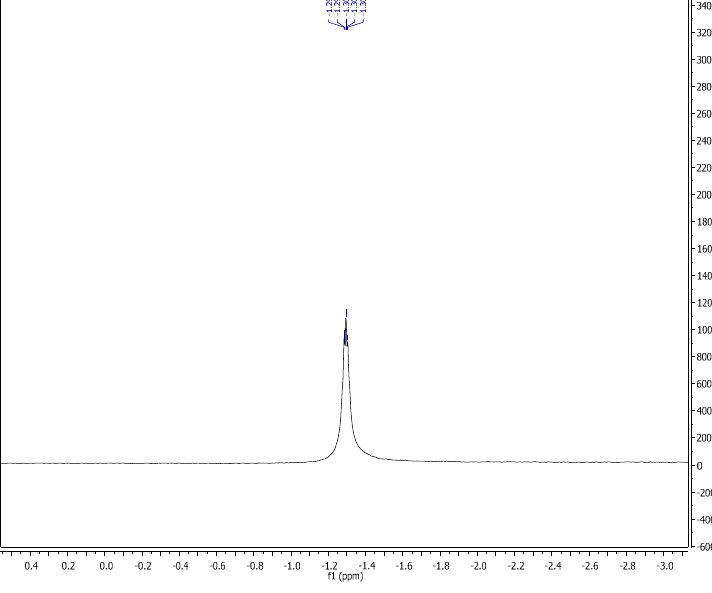
Figure 5. 11 B NMR spectrum of compound 2 5 .